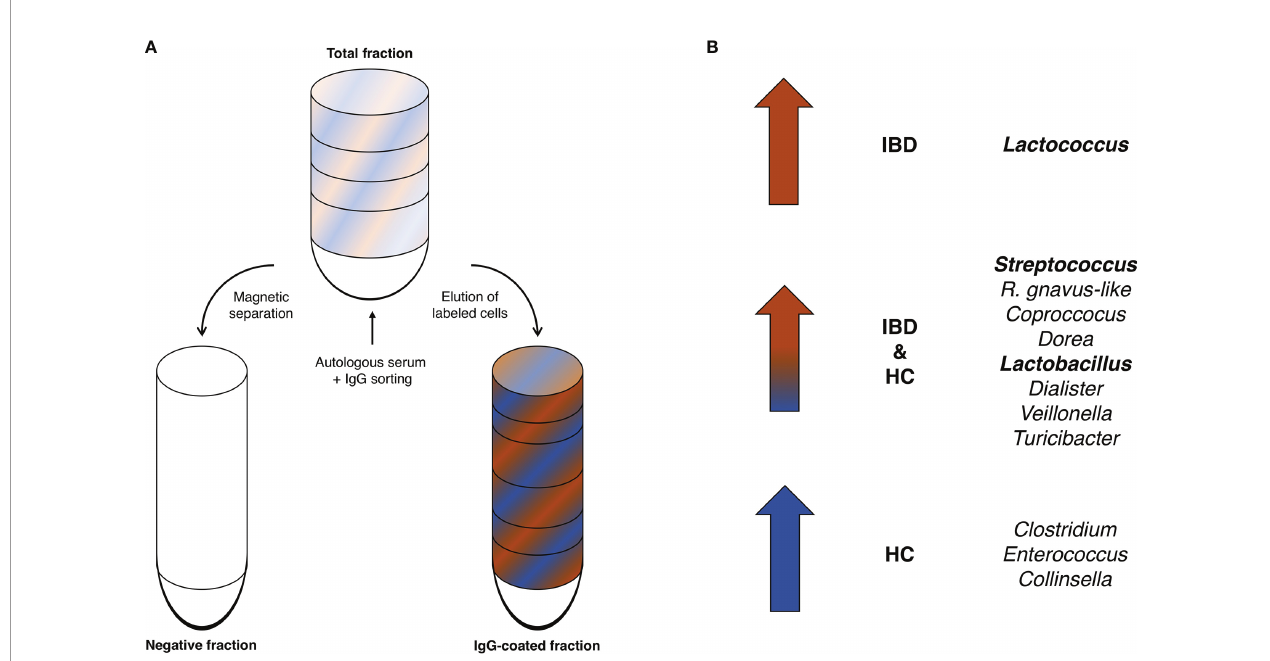
FIGURE 4 | (A, B) Enriched IgG-coated fecal bacterial genera in patients with IBD and HC. (A) Schematic illustration of the IgG-based MACS-sorting procedure. The total fraction (top) represents the original, untreated sample, while the IgG-coated fraction represents the fraction left after magnetic separation of the non-IgG- coated bacterial fraction (negative fraction). (B) The bacterial genera Streptococcus , Coprococcus, Dorea, Lactobacillus, Dialister, Veillonella, and Turicibacter as well as R. gnavus- like bacteria were signi fi cantly enriched in IgG-coated samples in both patients with IBD and HC. Lactococcus bacteria were signi fi cantly enriched after IgG-coating solely in patients with IBD and Clostridium , Enterococcus and Collinsella solely in HC. Bold indicates bacterial genera that were signi fi cantly more enriched in IBD vs.